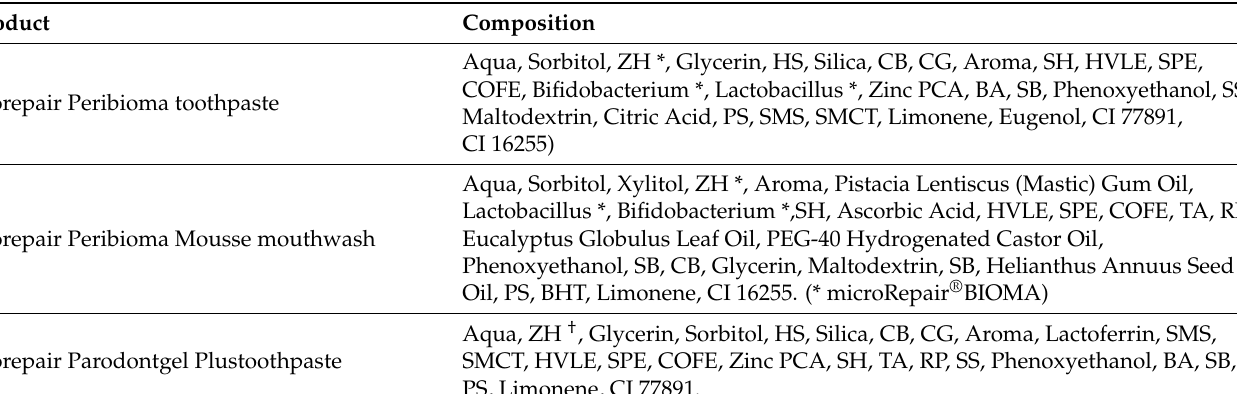
Table 1. Materials used in the study and their compositions [12,13].